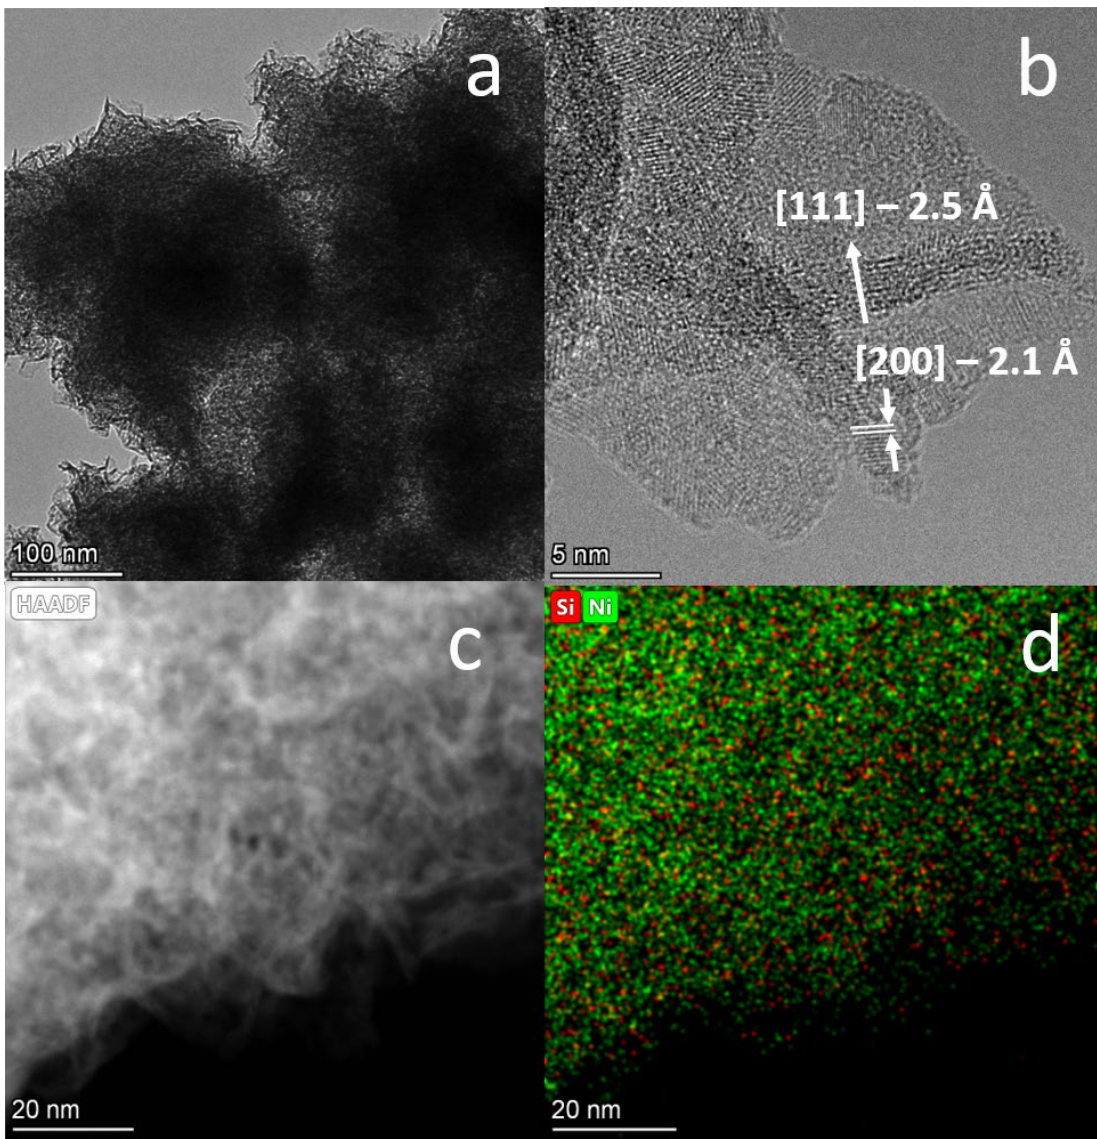
Figure 3. ( a ) TEM data; ( b ) HRTEM data; ( c ) the HAADF STEM image; ( d ) EDS mapping; Ni and Si atoms are green and red, respectively.